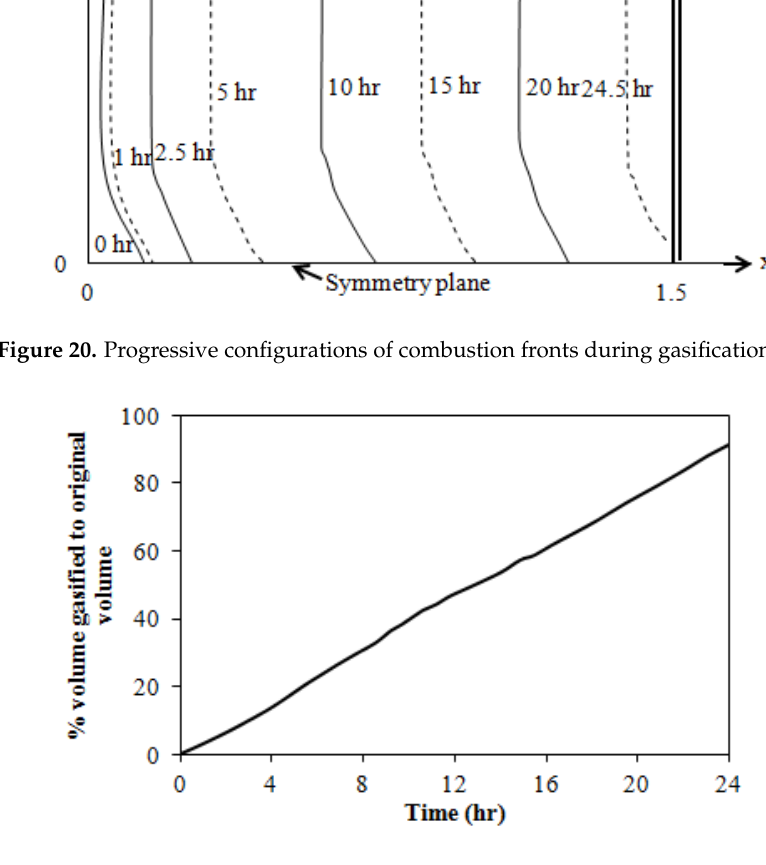
Figure 21. Consumption of coal during gasification [8].